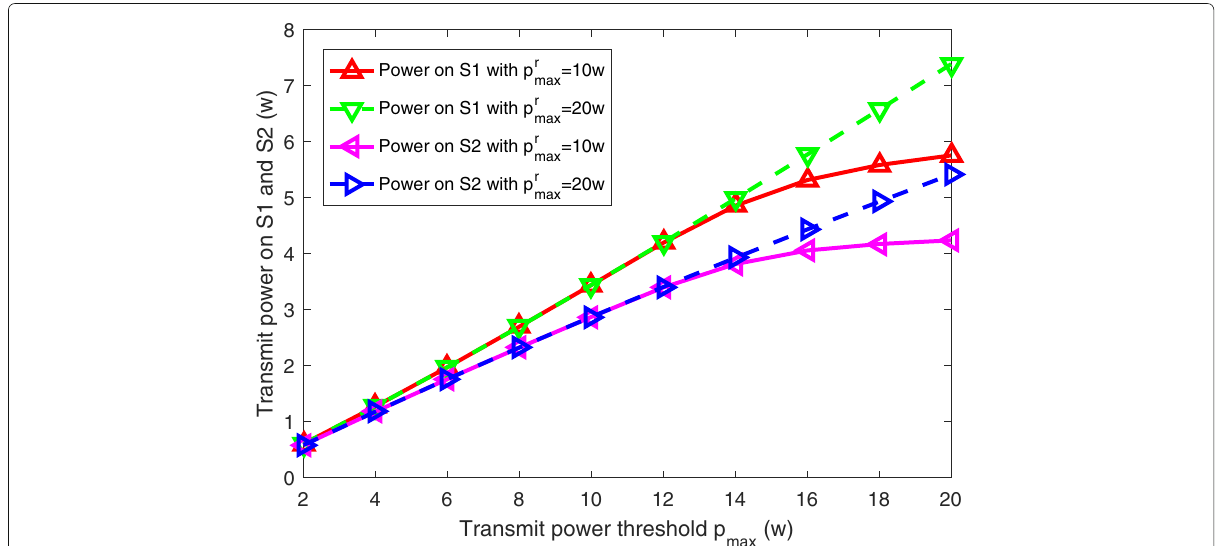
Fig. 4 Transmit power of the separated superposed signal with the increasing total transmit power threshold